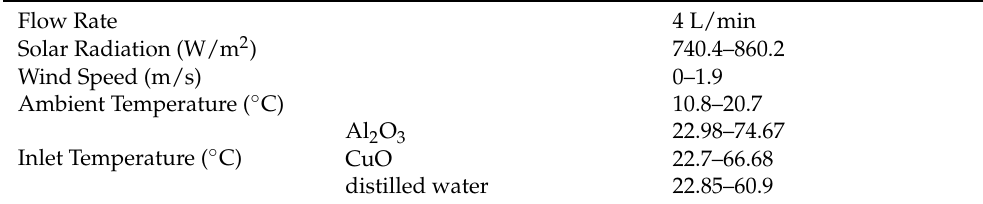
Table 3. The experimental conditions when the flow rate is 4 L/min.